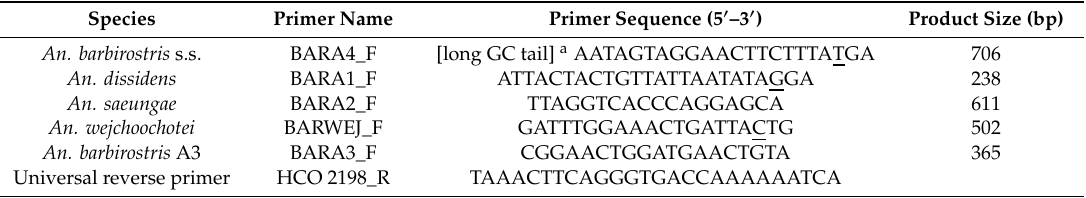
Table 2. Primers designed for the multiplex-PCR assay. Long GC tail was added to the allele-specific primer for An. barbirostris s.s. Mismatches of nucleotide bases are underlined. Species Primer Name Primer Sequence (5 (cid:48) –3 (cid:48)